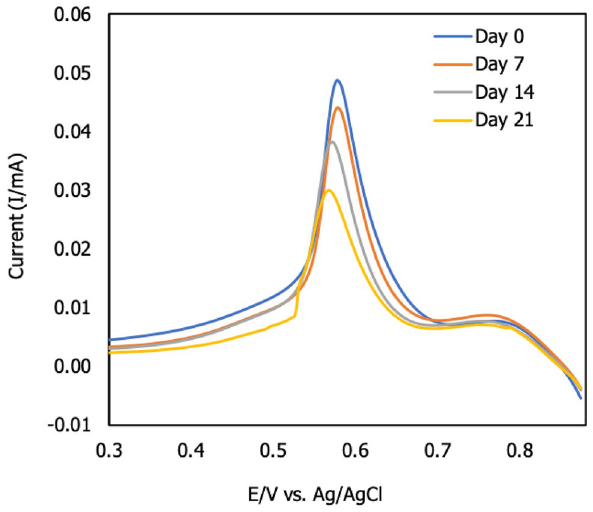
Figure 12. Effect of the storage stability test on modified electrode (f-MWCNTs/CS/PB/AuE) form day 7 to day 21. The modified electrode was measured in the presence of Zn 2+ ( n =